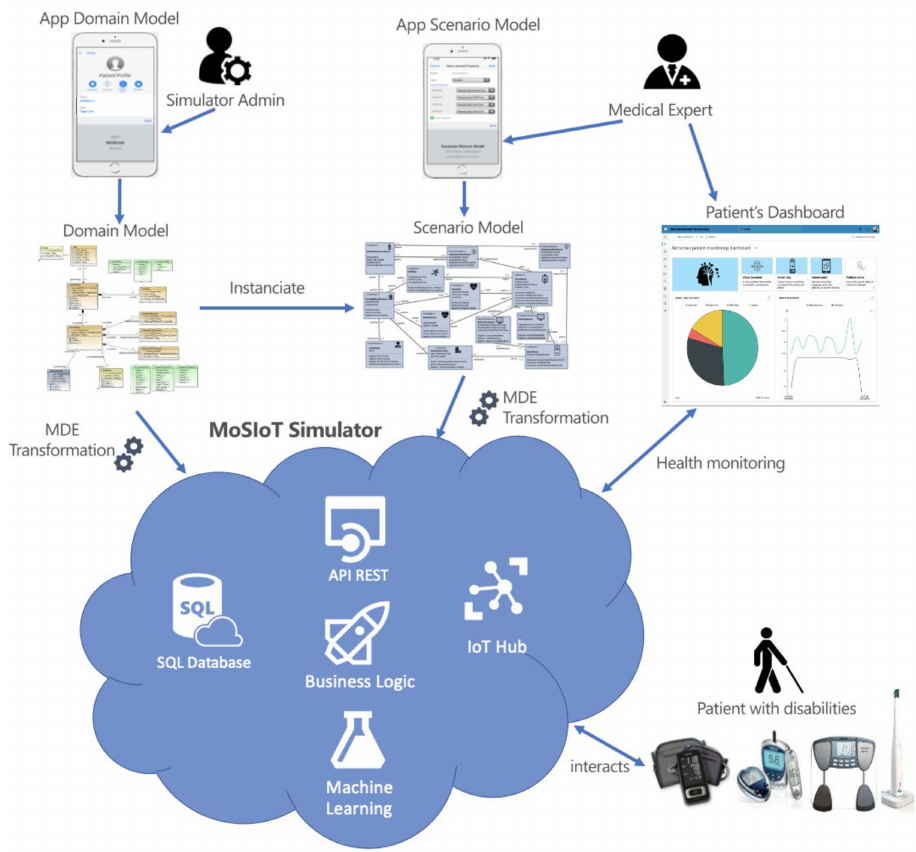
Figure 1. An overview of the MoSIoT